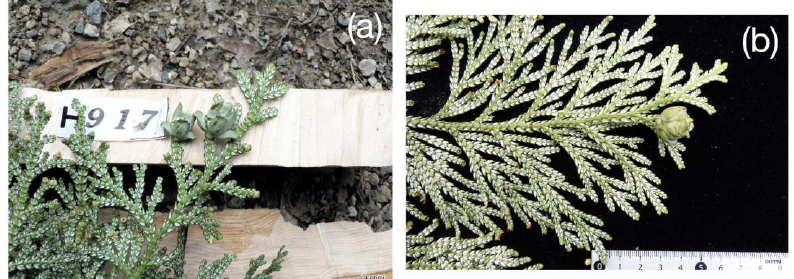
Figure A1. Typical morphology of ( a ) Thujopsis dolabrata (L.f.) Siebold et Zucc. var. dolabrata (Td) and ( b ) Thujopsis dolabrata (L.f.) Siebold et Zucc. var. hondae Makino (Th). Td ( a ) have horned cones, and